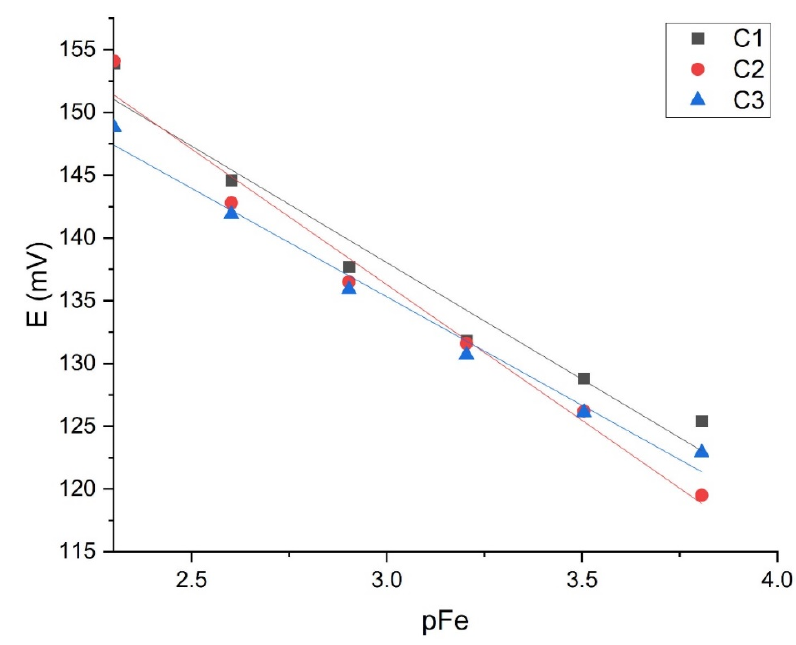
Figure 10. M1 intraday testing ( n = 3).